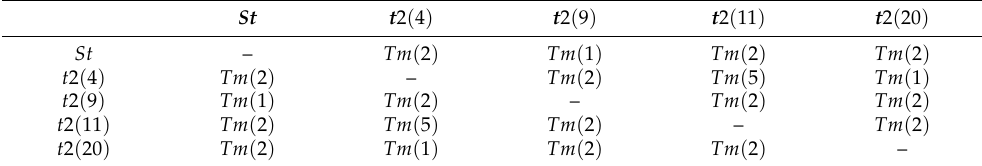
Table 6. The transportation modes chosen by the tourist in accordance with the recommended scenic spots.